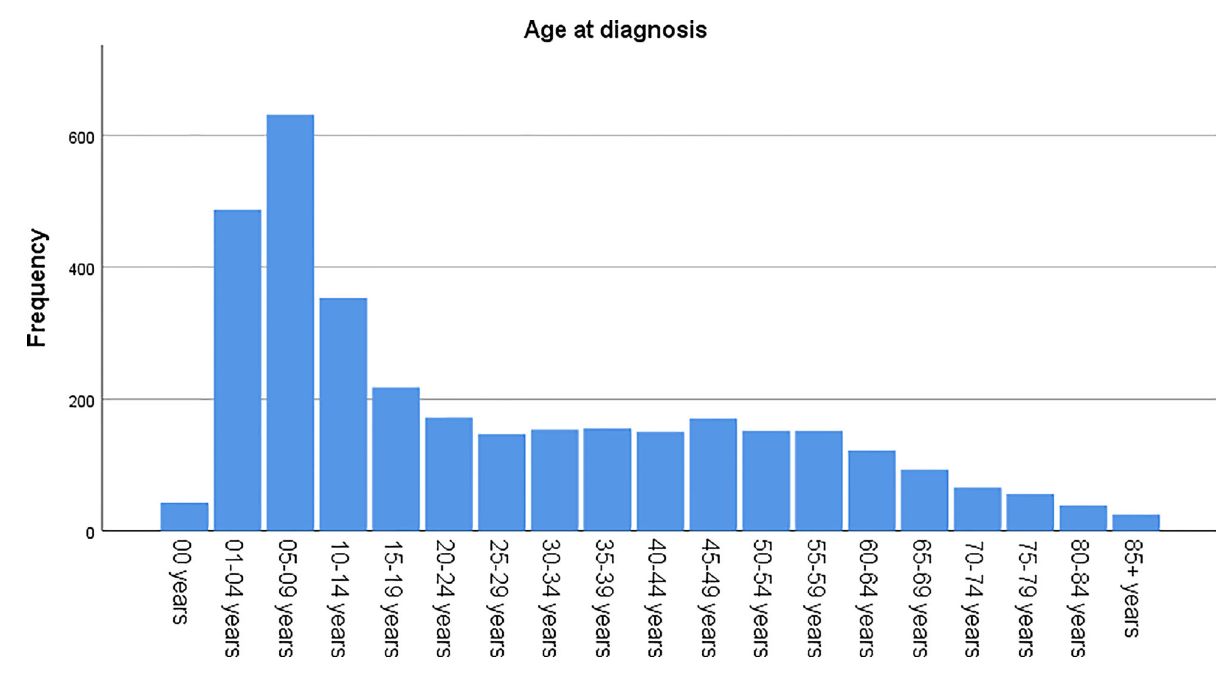
FIGURE 1 | Age distribution of the patients at diagnosis.